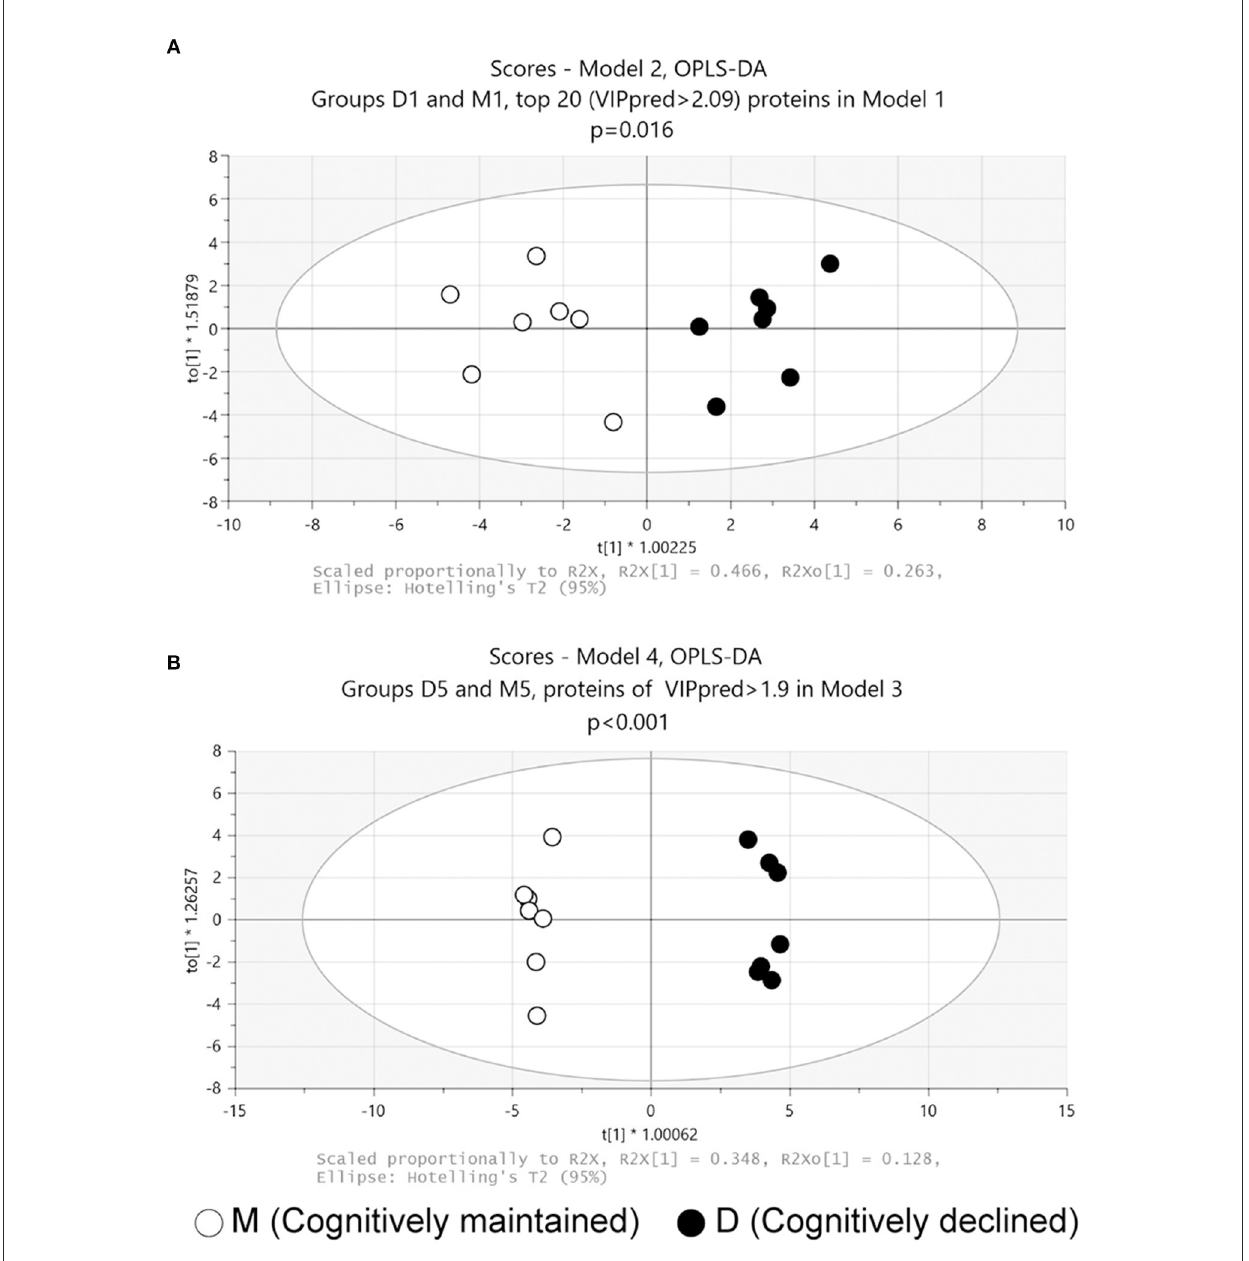
FIGURE1 Score plots of OPLS-DA models. (A) Model 2: Model 2 was generated using the top 20 proteins based on the predictive VIP score of the OPLS-DA model using all proteins in the proteome data at baseline. (B) Model 4: Model 4 was generated with 54 proteins with predictive VIP > 1.9 in the OPLS-DA model using all proteins in the proteome data at follow-up. p values obtained from CV-ANOVA are